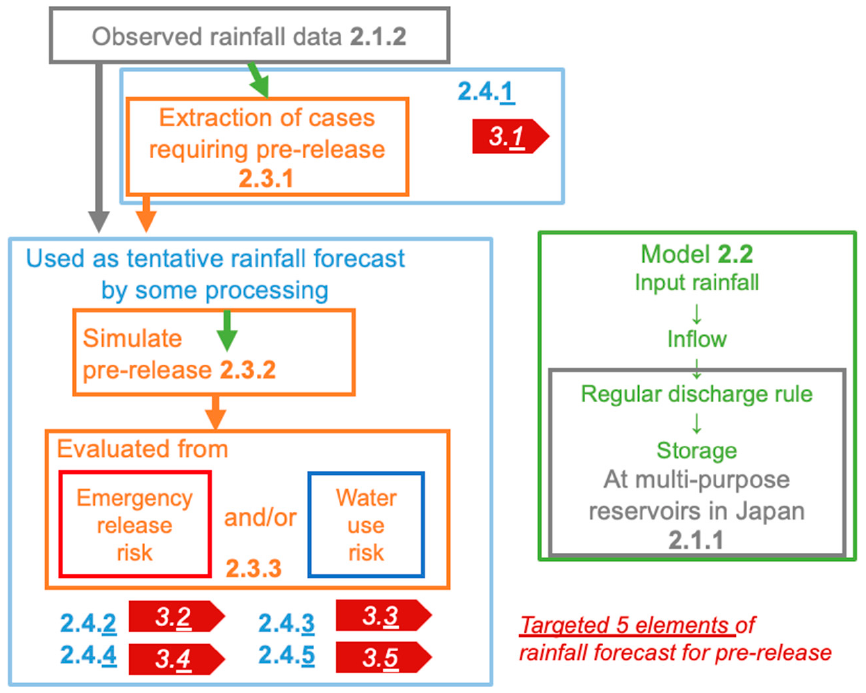
Figure 1. Flowchart about connections among subsections of second section.